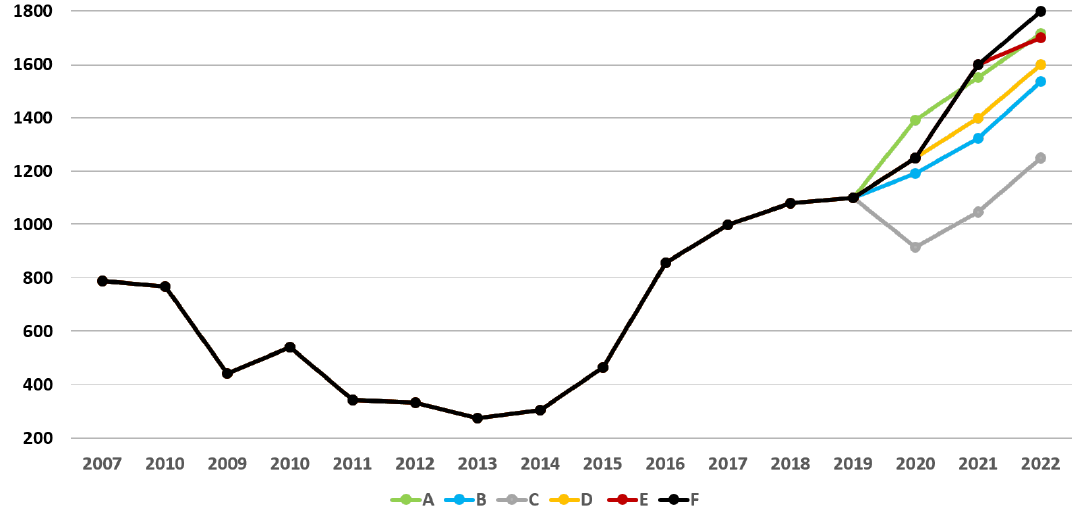
Figure 3. Market values (in million PLN) of the overload fraction to be developed.